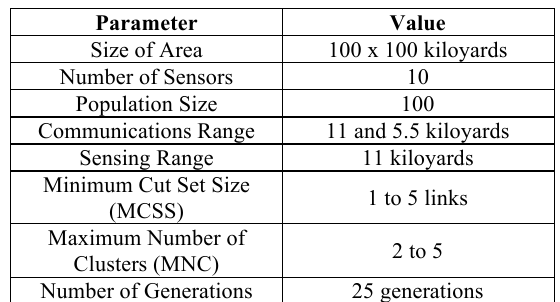
Table 4. USDEA Parameters Used in the